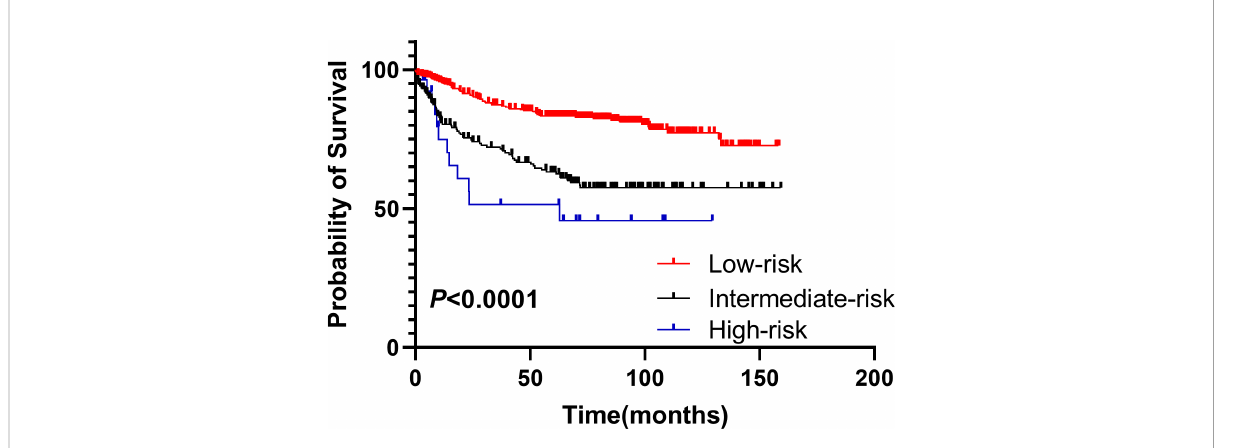
FIGURE 2 Strati fi cation of OS of DLBCL patients using the prediction model. Overall survival of patients in groups classi fi ed as low-, intermediate -, and high-risk based on the pneumonia prediction model. DLBCL, diffuse large B-cell lymphoma; OS, overall survival.